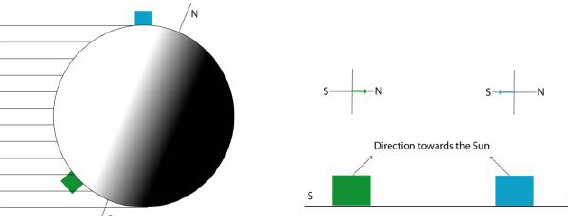
Figure 2. Direction of the sun at different hemisphere measured from